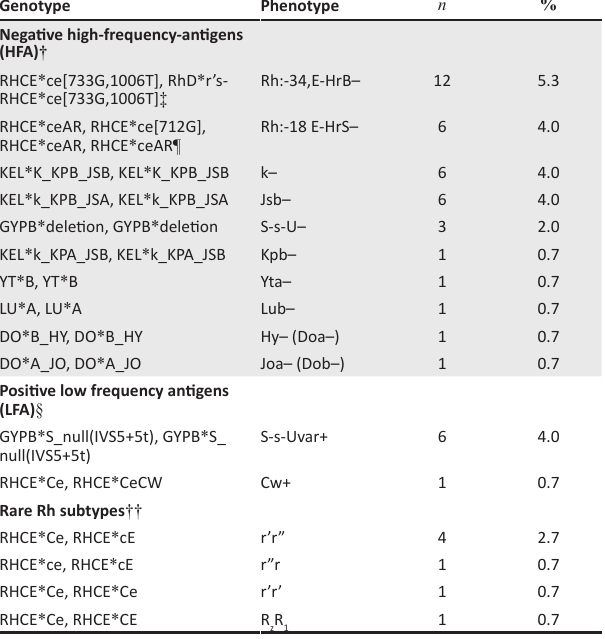
donors genotyped between January 2012 and August 2016 at the South African National Blood Service, Immunohaematology Reference Laboratory. Genotype Phenotype n Negative high-frequency-antigens (HFA)